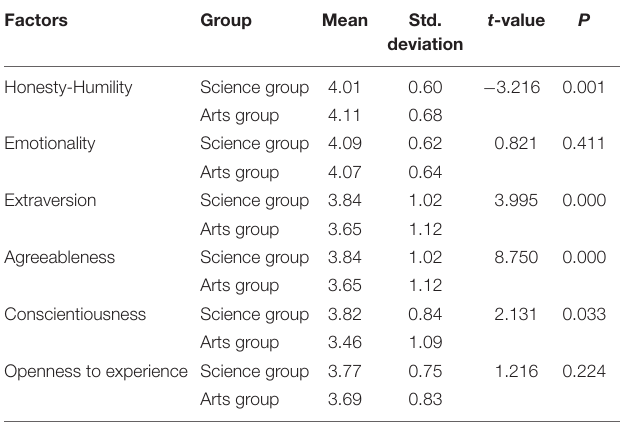
TABLE 6 | Comparison between science and arts higher achievers’ students’ personality traits. Factors Group